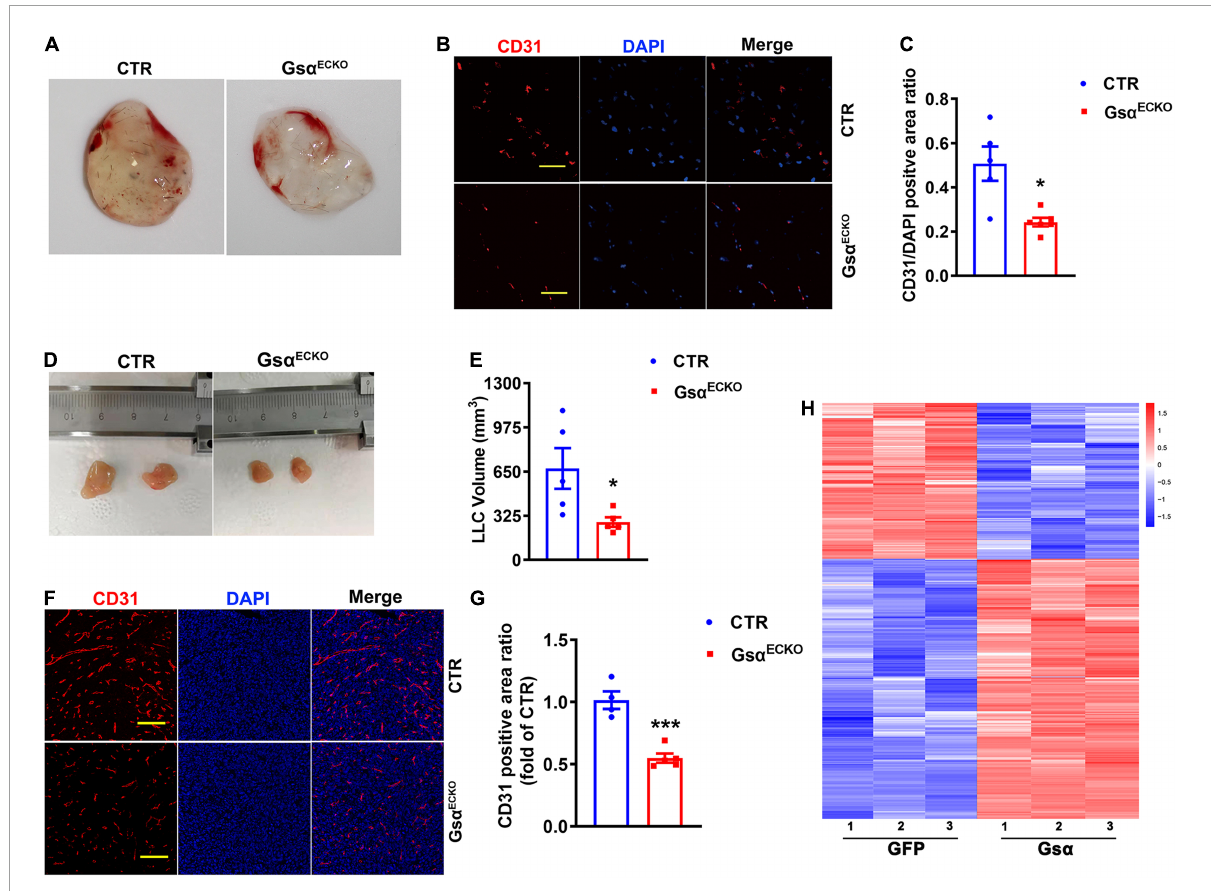
FIGURE3 Loss of endothelial Gs α inhibits neovascularization and tumor growth in vivo . (A) Representative matrigel plugs retrieved from CTR and Gs α ECKO mice. (B) Representative immunofluorescence staining of CD31 and DAPI in matrigel plugs. Scale bar, 50 µ m. (C) Quantification of the ratio of CD31-positive to DAPI staining. n = 5 for CTR; n = 6 for Gs α ECKO . (D) Images of LLCs harvested from CTR and Gs α ECKO mice. (E) Quantification of tumor volume. n = 5/group. (F) Representative immunofluorescence staining of CD31 and DAPI from LLC tumors. Scale bar, 100 µ m. (G) Quantification of the ratio of CD31-positive area. n = 4 for CTR, n = 5 for Gs α ECKO , * P < 0.05, *** P < 0.001 vs. CTR (unpaired Student’s t -test). Data are mean ± SEM. (H) Transcriptome sequencing of genes with > 1.5- fold upregulation or > 1.5-fold down-regulation in Gs α virus transfected HUVEC compared with